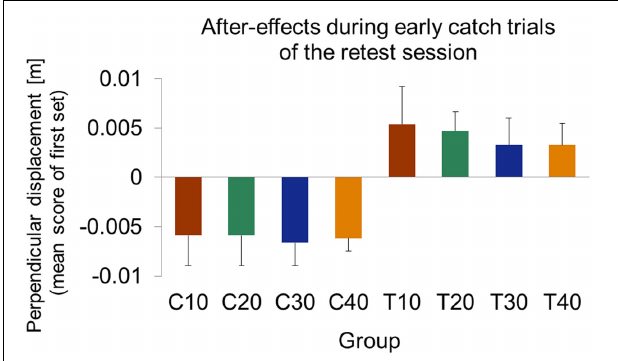
FIGURE 9 | Mean values of signed perpendicular displacement in catch trials of the first movement set at retest of force field A (day 3). All control groups show significant negative after-effect values indicating predictive force compensation appropriate to force field A. Test groups show significant positive after-effect values indicating predictive force compensation appropriate to force field B. All data is presented as mean ± 95% confidence